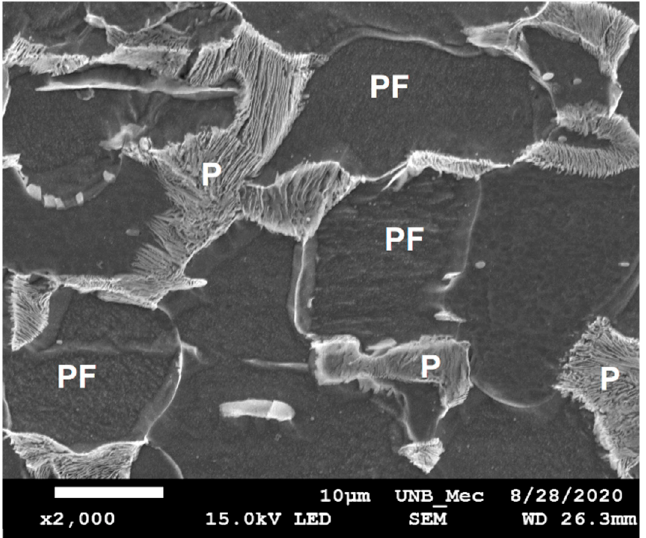
Figure 9. SEM image of SHAZ (2000× ampliation). Etching: Nital 5%.